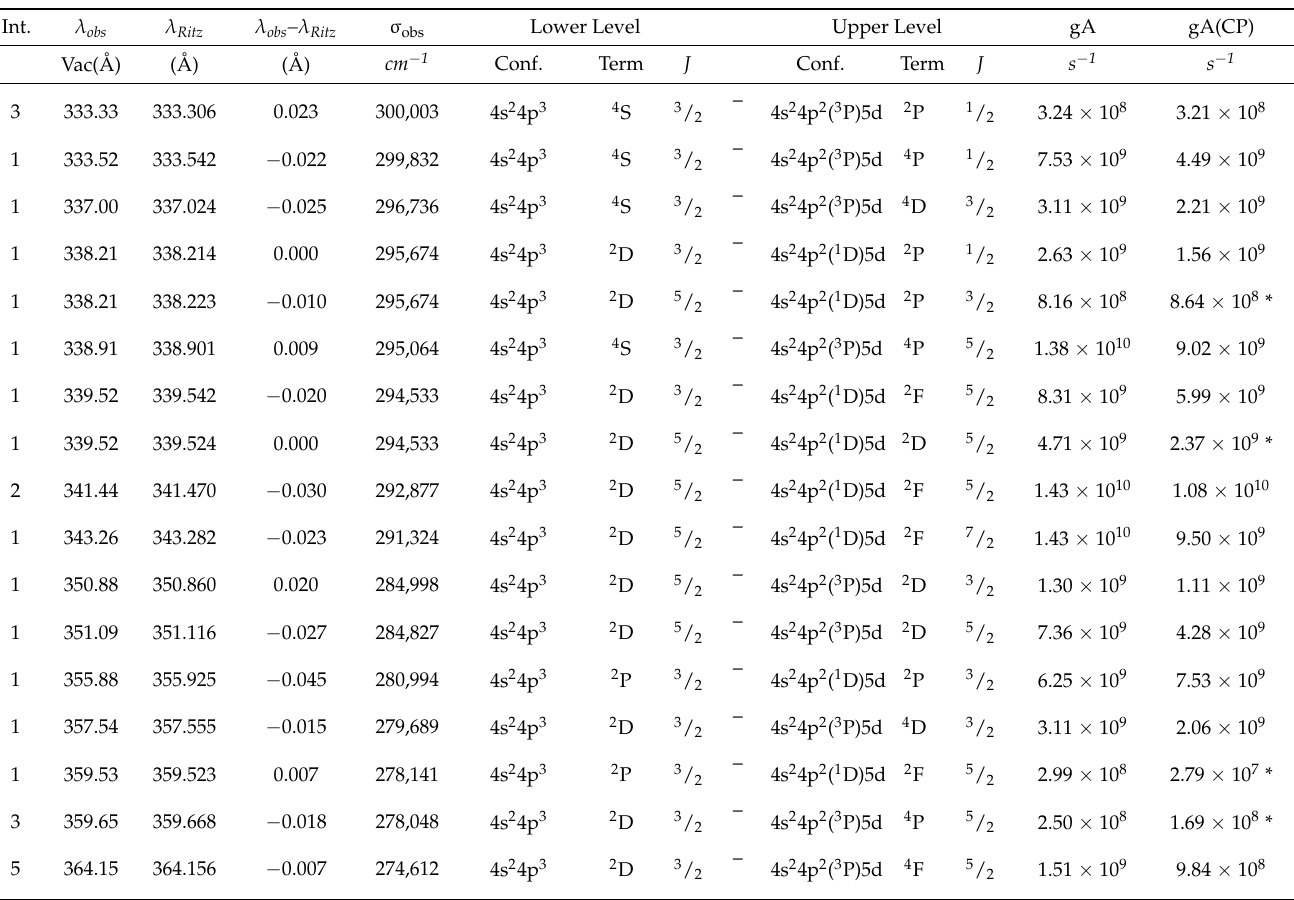
Table 1. New classified lines of Kr